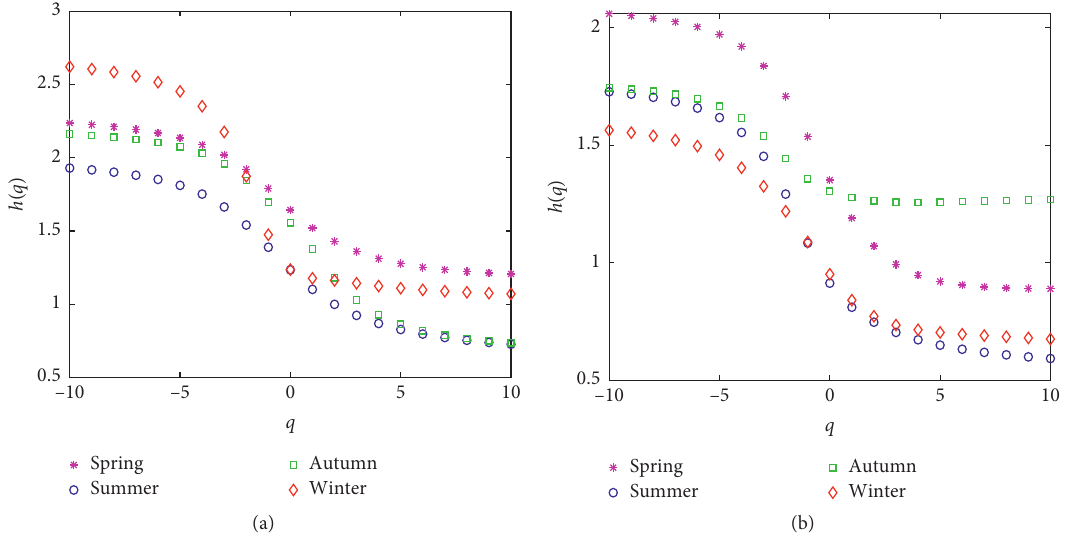
Figure 3: Hurst exponent of (a) PM Table 3: Multifractality for PM